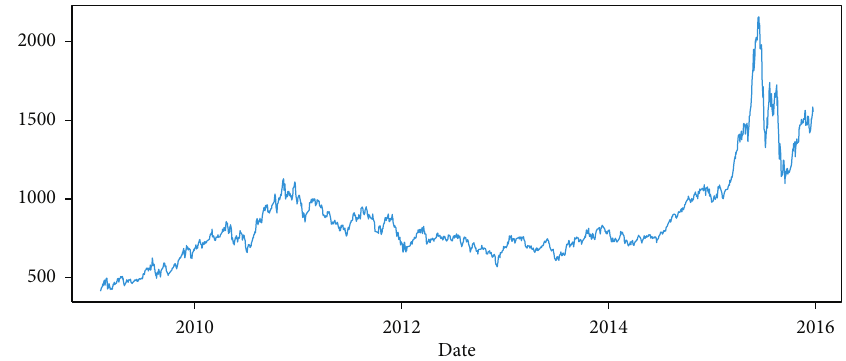
Figure 1: The Chinese agriculture index from February 2, 2009 to December 24, 2015.